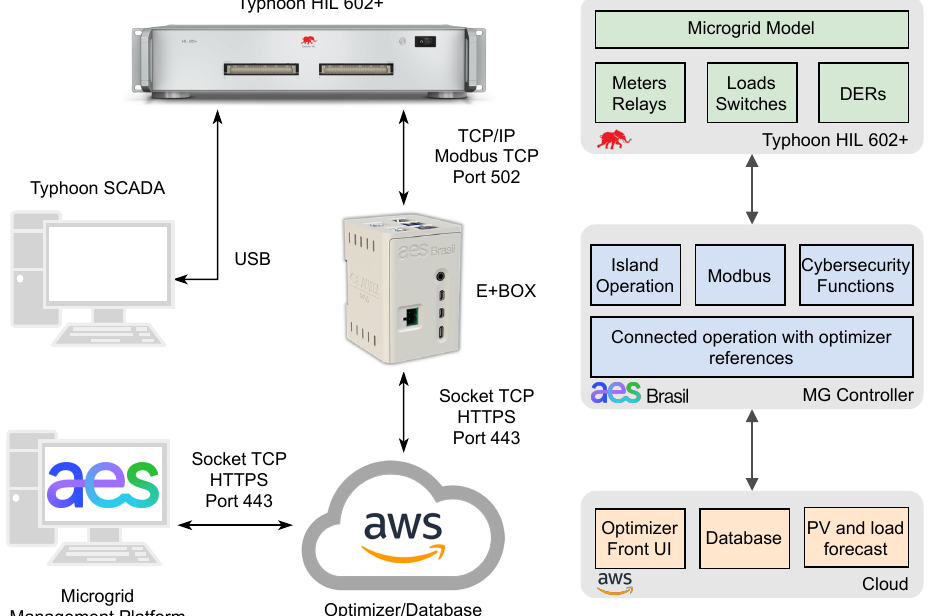
Figure 5. COGE MG setup